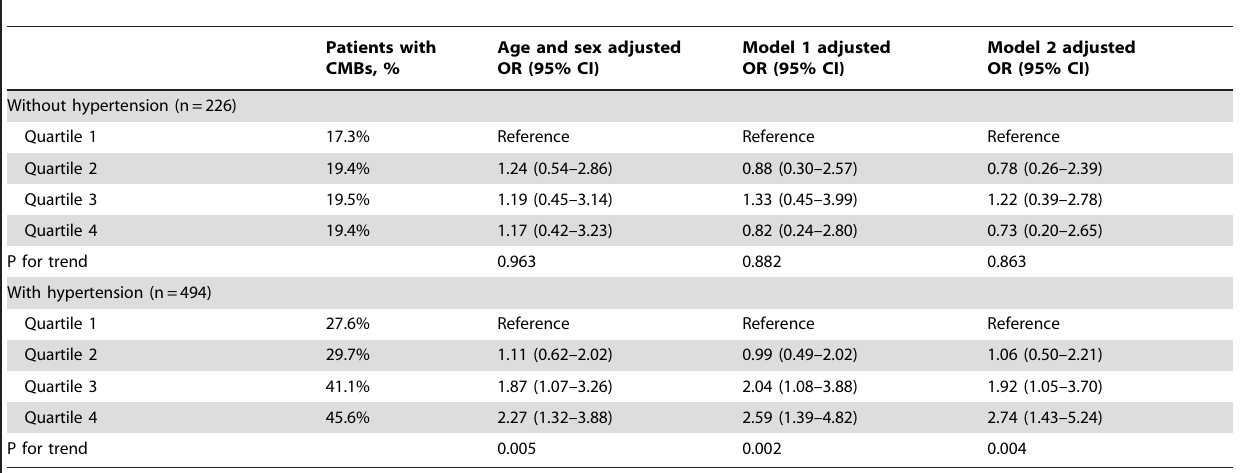
Table 4. Multivariable Logistic Regression Analysis for Presence of Cerebral Microbleeds in Patients with or without